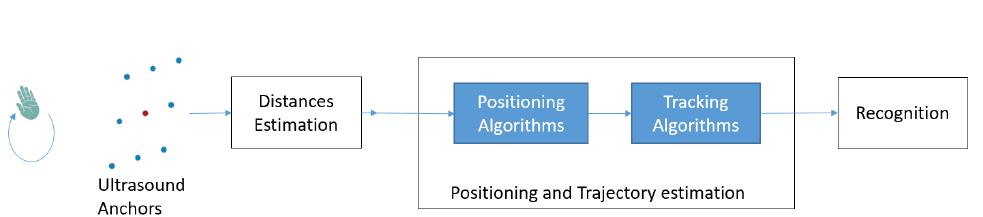
Figure 1. Ultrasound positioning system used as a reference for the